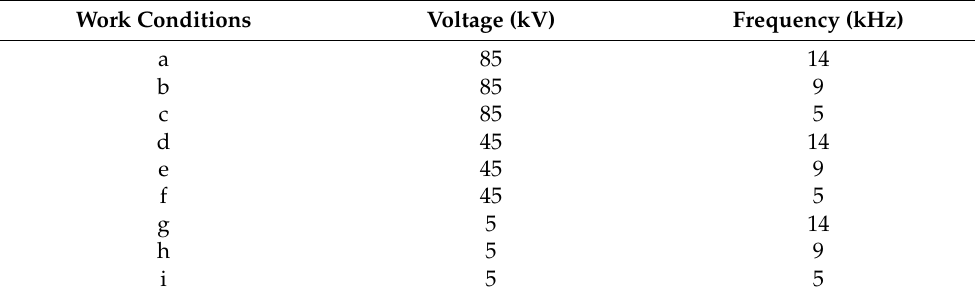
Table 4. Different actuation intensities with 20 mm actuation length on inner surface.